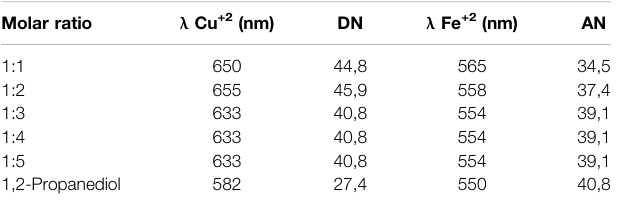
TABLE 4 | Absorption maxima ofsolvatochromic dyes and the corresponding AN andDNassociatedforaseriesofcholinechloride – 1,2-propanediol atdifferent molar ratios at 25 °